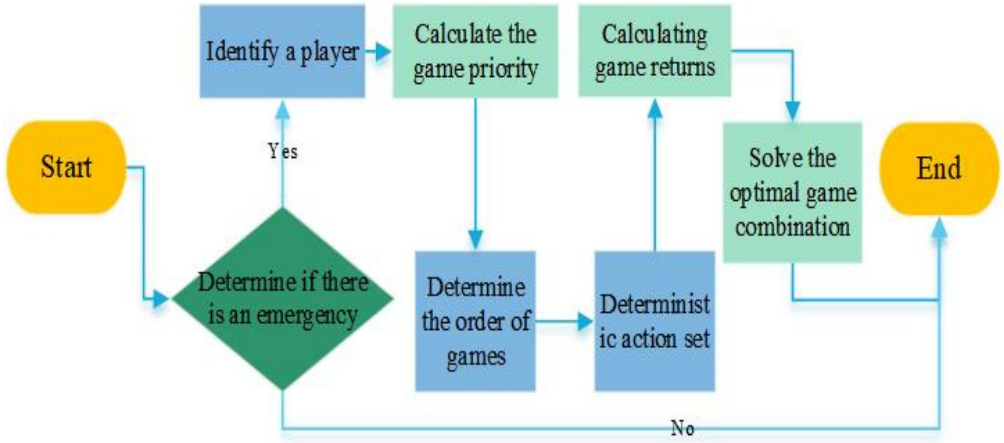
Figure 5. Flow chart of ship collision avoidance strategy in the perfect information game.